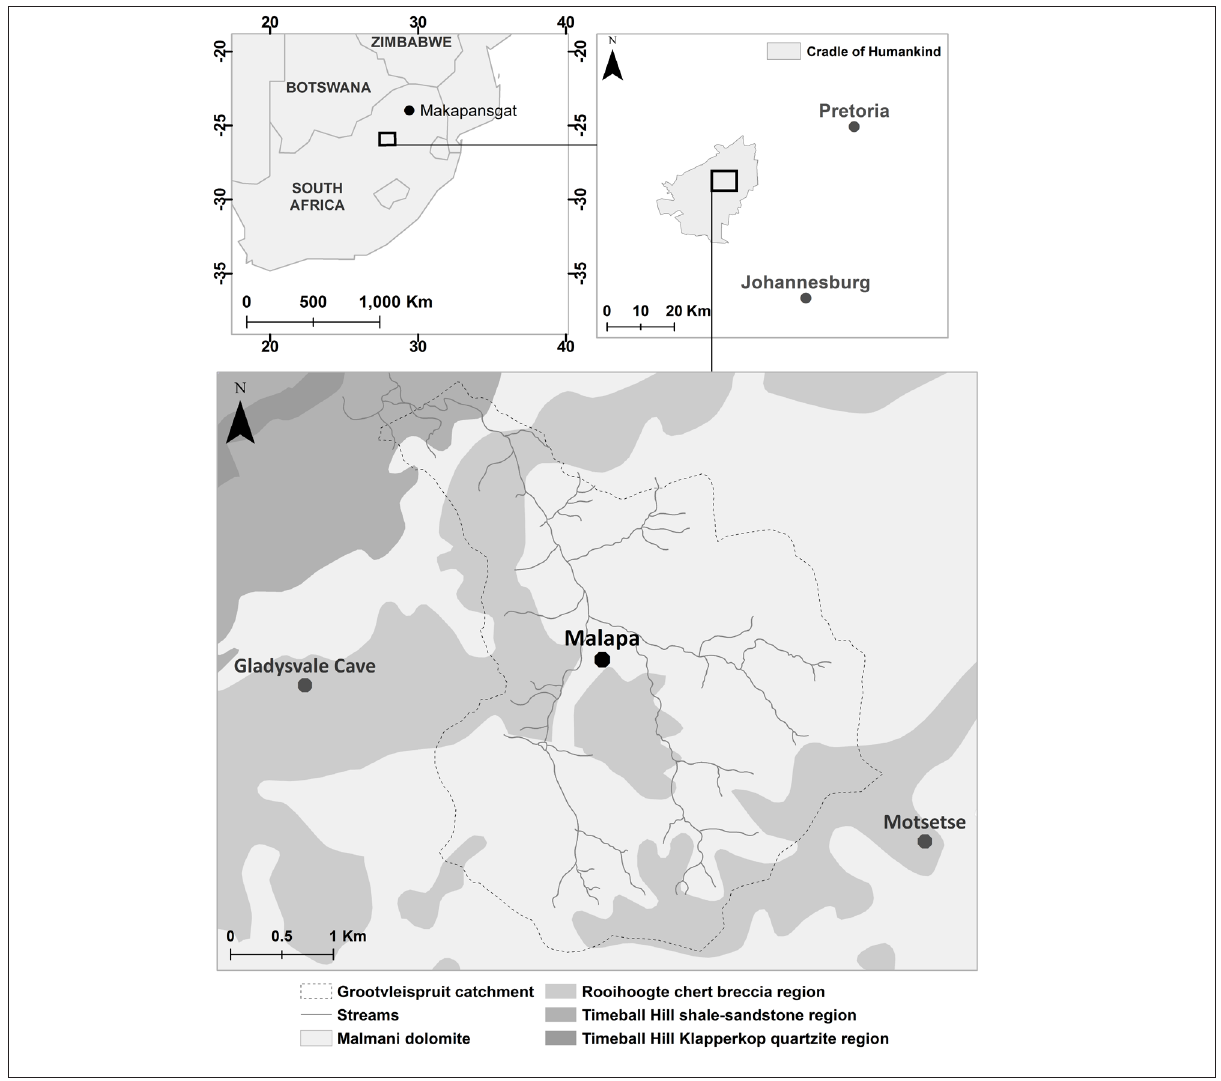
Location and geological setting of Malapa. Also shown is the location of another important hominin fossil site in South Africa, the Makapansgat Valley in Limpopo